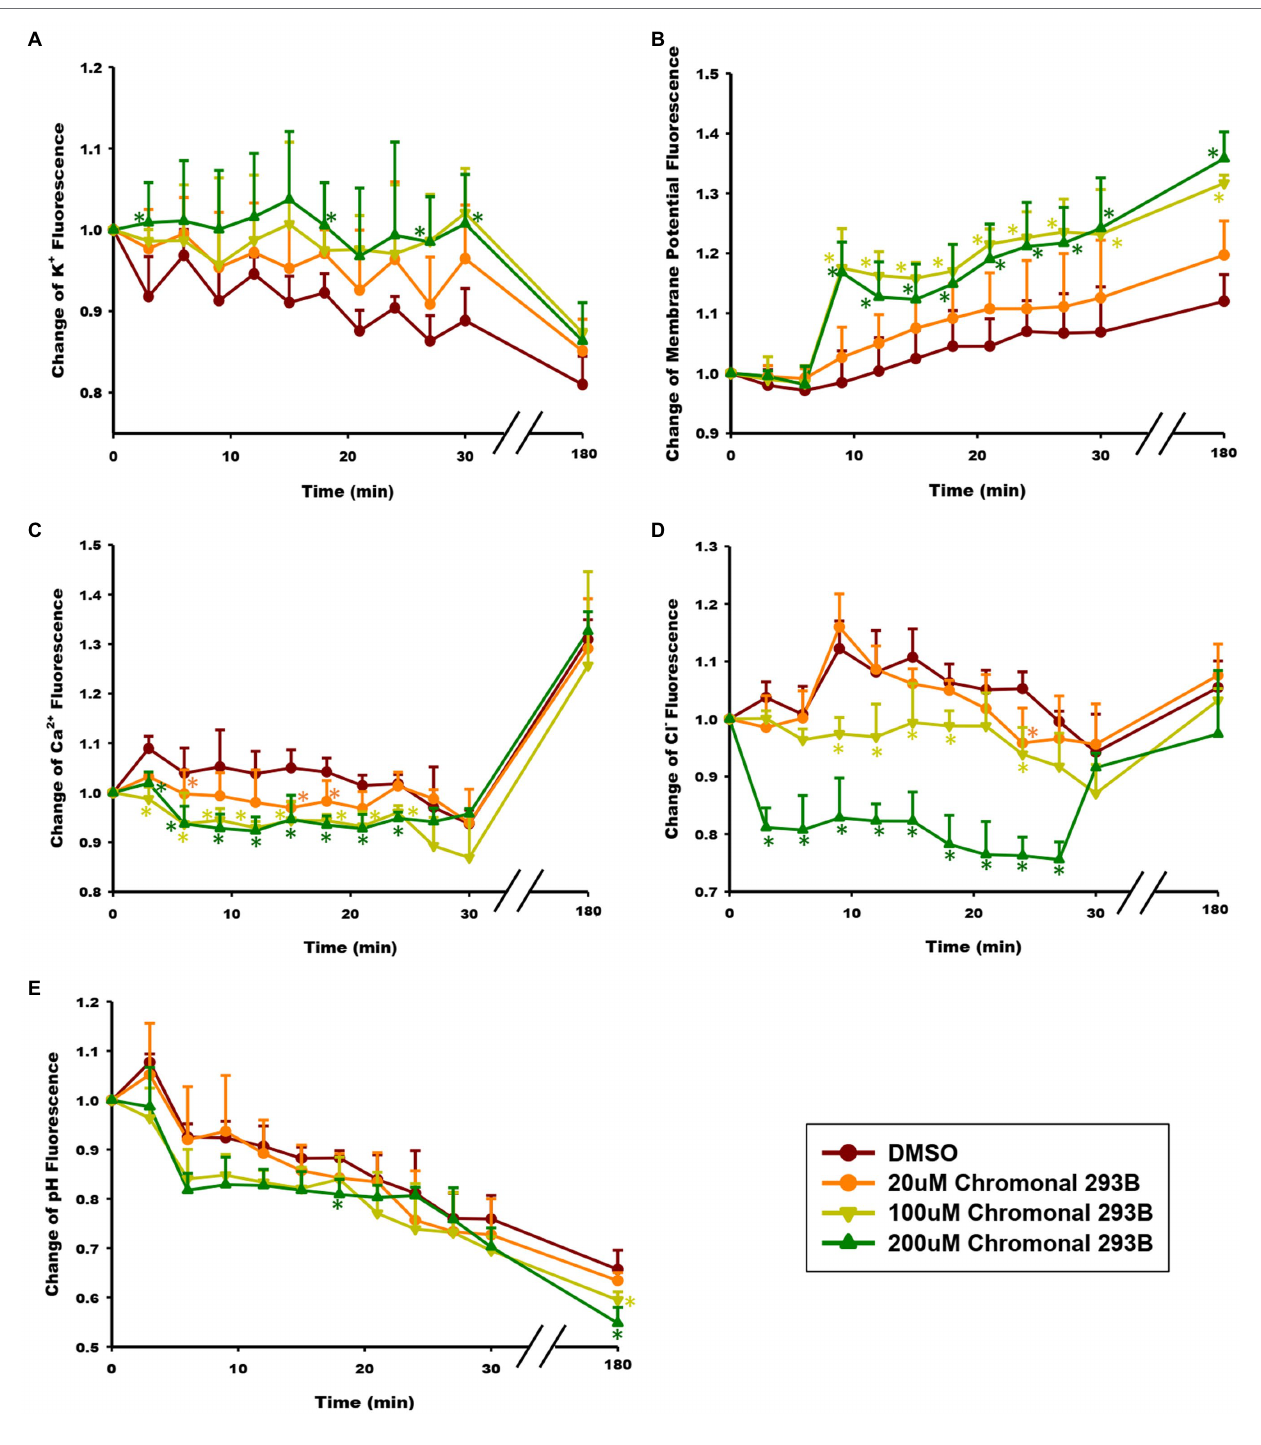
FIGURE 4 | Effect of chromanol 293B on ion homeostasis during human sperm capacitation. (A) Intracellular K + concentration ([K + ] i ) was detected using the K + fluorescence probe PBFI-AM. The fluorescence intensity was directly proportional to [K + ] i . (B) Human sperm membrane potential (V m ) was analyzed using the fluorescence probe DisC3(5). The fluorescence intensity was directly proportional to V m . (C) Intracellular Ca 2+ concentration ([Ca 2+ ] i ) was detected using the Ca 2+ fluorescence probe Fluo3-AM. The fluorescence intensity was directly proportional to [Ca 2+ ] i . (D) Intracellular Cl − concentration ([Cl − ] i ) was detected using the Cl − fluorescence probe MQAE. The fluorescence intensity was inversely proportional to [Cl − ] i . (E) Intracellular pH (pH i ) was analyzed using the pH fluorescence probe BCECF-AM. The fluorescence intensity was directly proportional to pH i . All the data were acquired at 3 min intervals for 30 min during capacitating incubation. After capacitation for 3 h, the fluorescence signal was acquired again. Asterisks indicate the significant differences between samples and vehicle control at the same time point ( * p < 0.05). The exact P value were provided in the supplementary data ( Table S1 ). Values represent the means ± SEM of 3